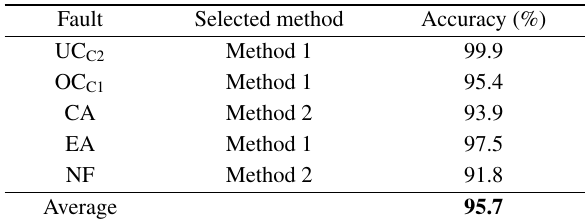
Table 10 Tradeoff method